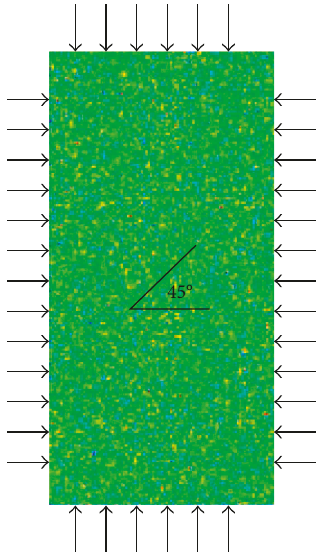
Figure 4: RFPA model diagram under the triaxial compression.